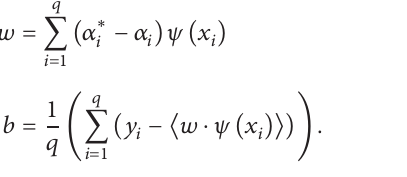
Figure 4, u (𝑡) ∈ 𝑅 𝐿 is the temporal input, and 𝑦(𝑧, 𝑡) ∈ 𝑅 is the spatiotemporal output, where 𝑡 is the time variable, 𝑧 ∈ 𝑍 is the spatial variable, and 𝑍 is the spatial